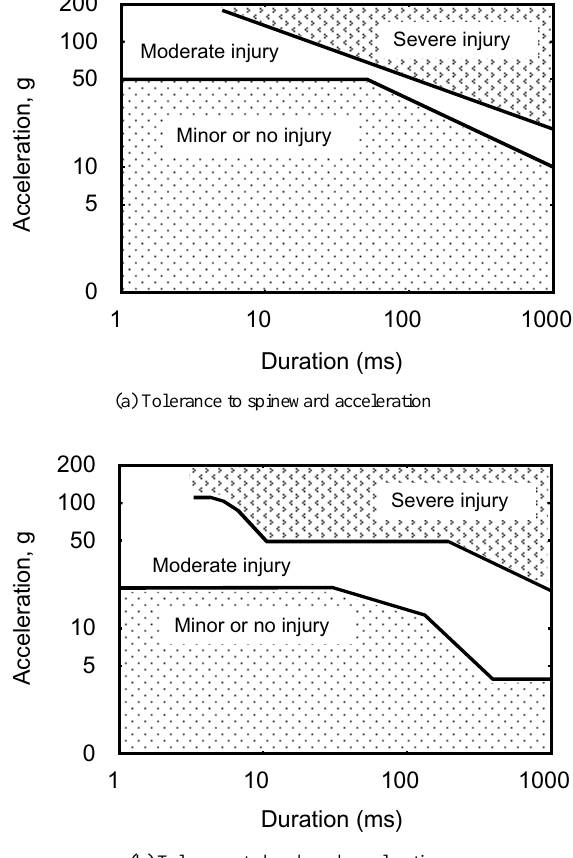
Fig. 2. Whole-body tolerance criterion to acceleration